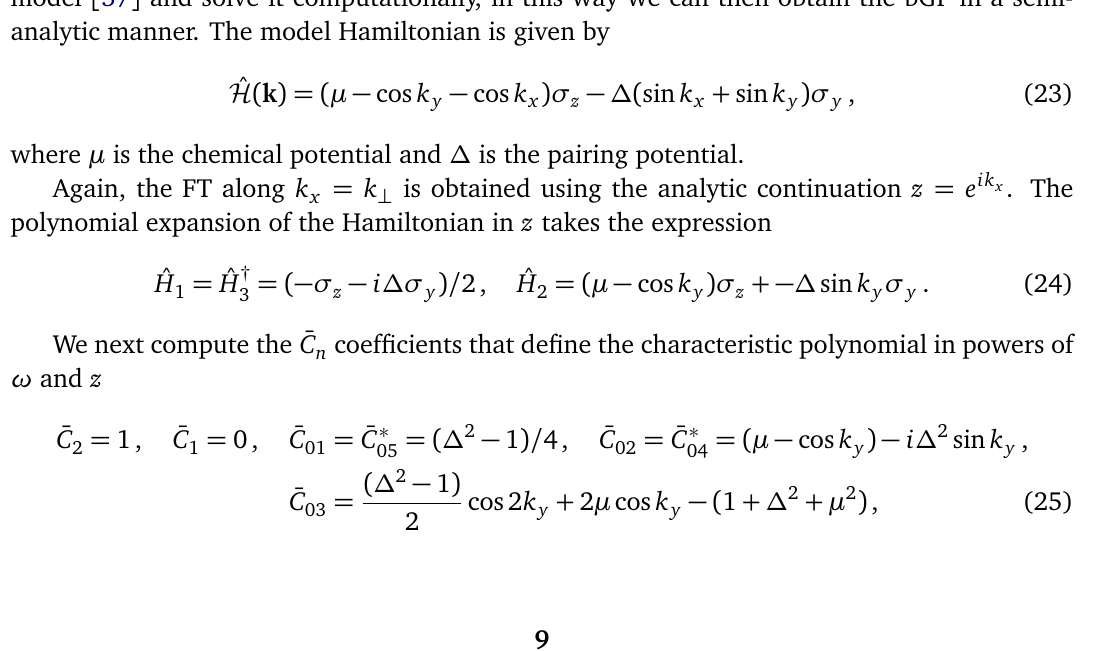
Figure 4: Open boundary characterization for the Chern Insulator model showing chiral edge states under the effect of the mass term M → 1. a) Electronic bands obtained by exact diagonalization of a finite size system with N spectrum shows 2 chiral edge states each one associated to a different boundary. b) Spectral density for a right boundary in the semi-infinite limit obtained from the bGF calculation. c) Integrated LDOS where straight (dot-dashed) line represents bulk (right boundary)